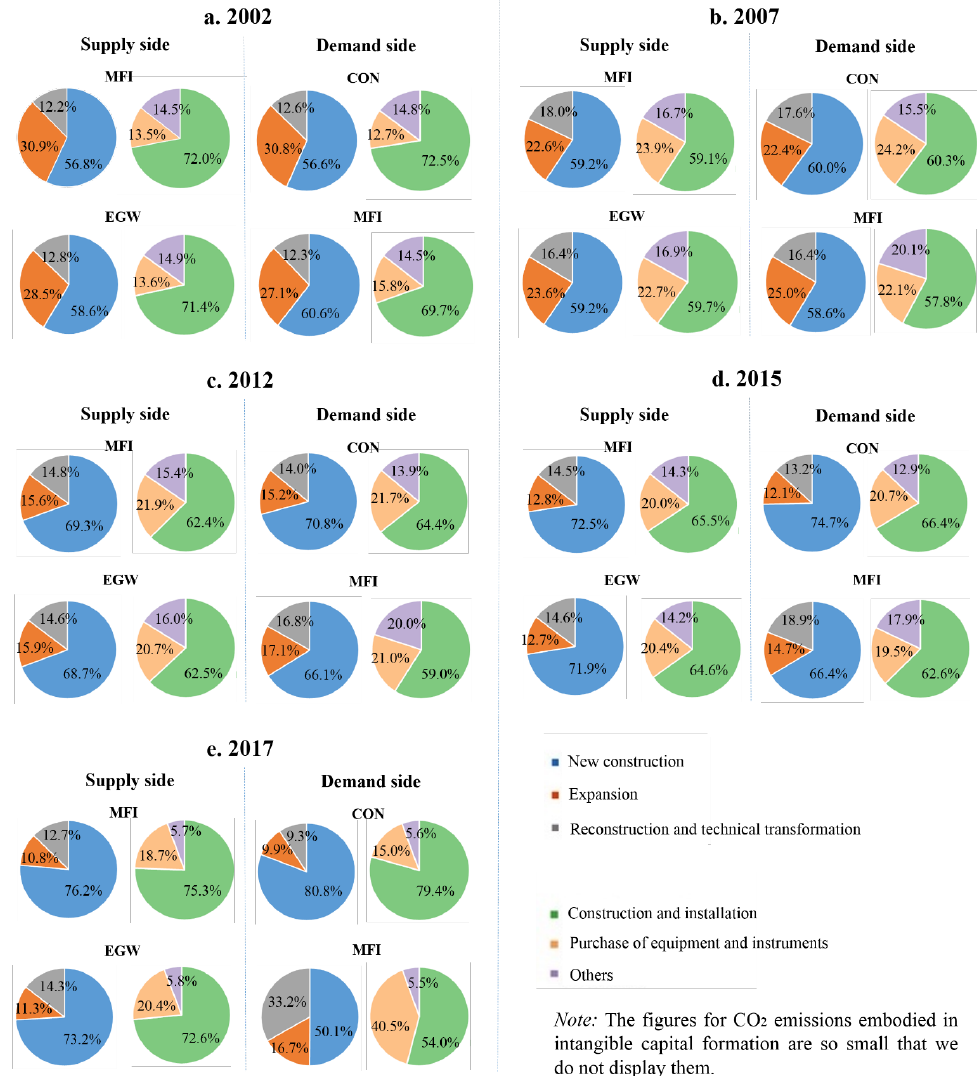
Figure 4. Compositions of CO 2 emissions embodied in FCF in main sectors from both supply-side and demand-side perspectives.